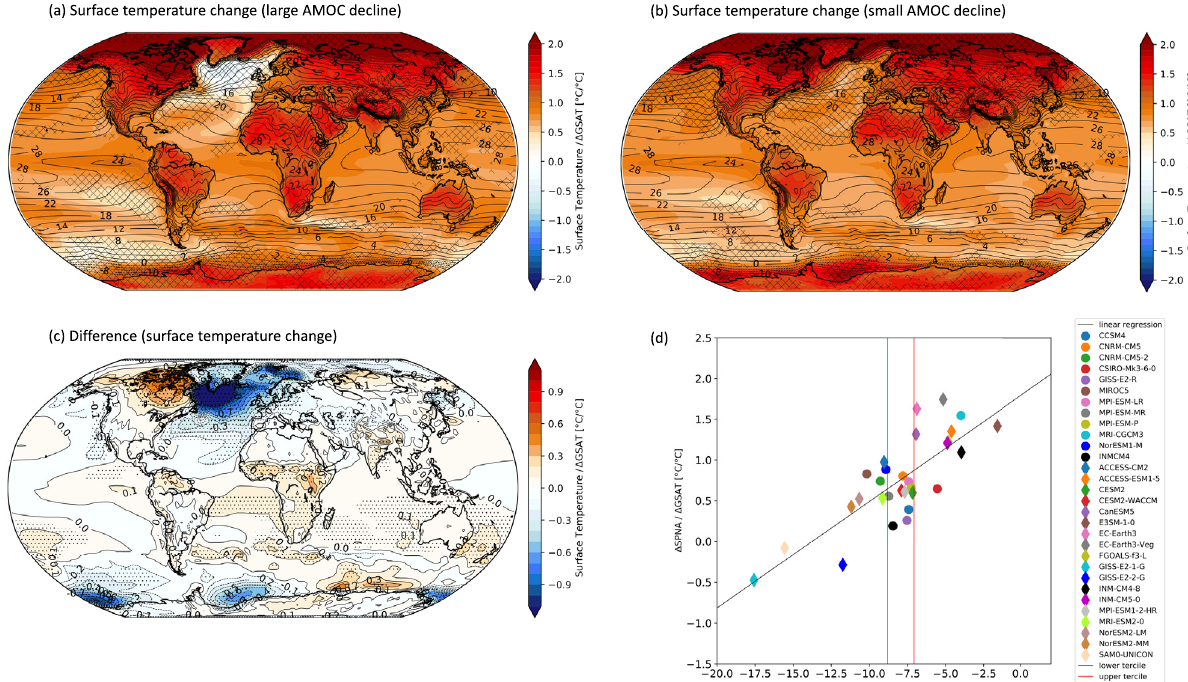
Fig. 2 Surface temperature change associated with AMOC. Panels a , b show the normalized annual mean surface temperature change in the abrupt- 4xCO 2 with respect to the preindustrial control for a the average of the large AMOC decline group and b the average of the small AMOC decline group. Panel c is their difference (a minus b). For each model, surface temperature change is divided by the respective Δ GSAT, hence units are °C per degree of global warming. In panels ( a ) and ( b ), superimposed contours show the climatological mean surface temperature computed from all models. In panel c , superimposed contours show the numerical values associated with the surface temperature differences of the colored contours. Panel d shows the change in subpolar North Atlantic SST ( Δ SPNA) divided by Δ GSAT, against AMOC change ( Δ AMOC) in units of Sv. Circles represent CMIP5 models, while diamonds represent CMIP6 models. The dashed black line is the linear regression ( y ¼ 0 : 13 x þ 1 : 8) with R 2 : 0.63. The blue and red vertical lines represent the lower and upper terciles of the Δ AMOC distribution. Models to the left of the blue line belong to the large AMOC decline group, while models to the right of the red line belong to the small AMOC decline